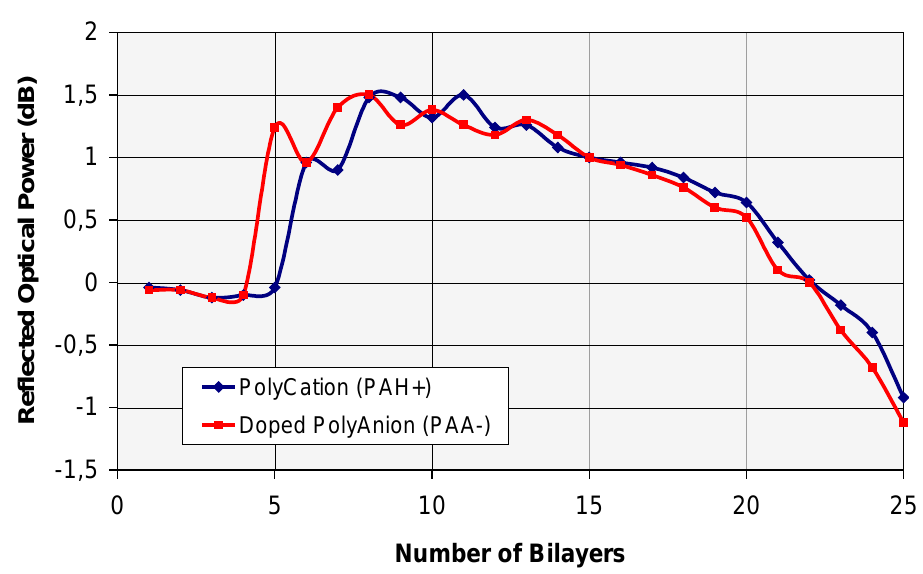
Figure 4. Construction curve of the nano Fabry-Perot for the polycation (PAH + ) and the polyanion (PAA − ) doped with the vapochromic